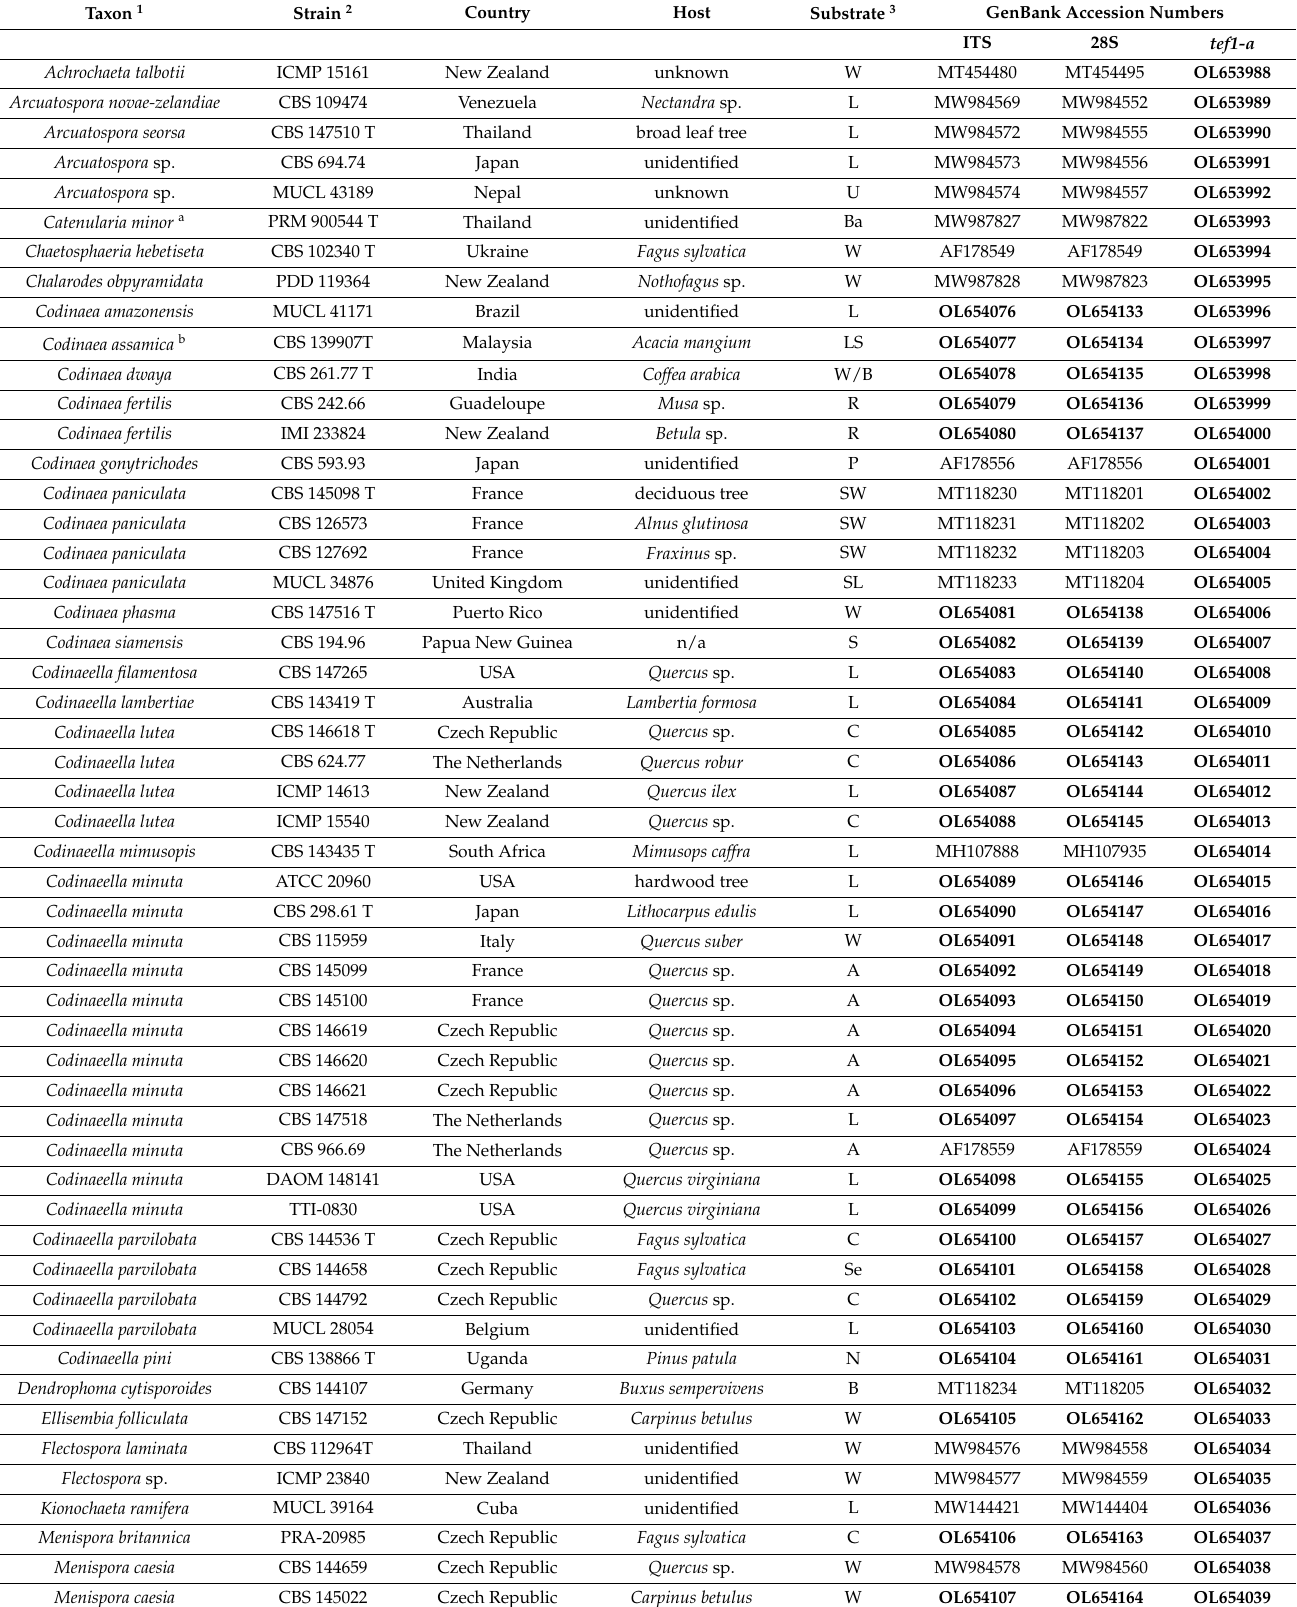
Table 1. Taxa, isolate information, and GenBank accession numbers for sequences. New sequences determined for this study and taxonomic novelties are given in bold